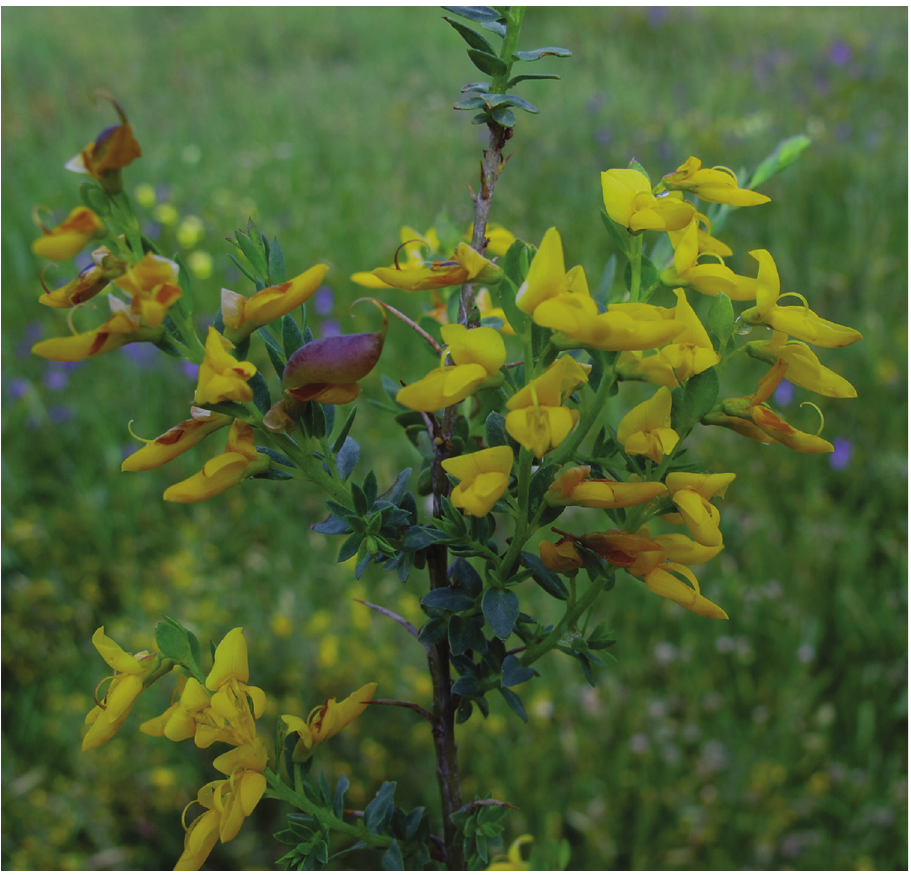
Figure 3. Genista anglica at Silvana Mansio (Serra Pedace, Cosenza; Calabria), a locality included in the Sila National Park. Photograph by L.